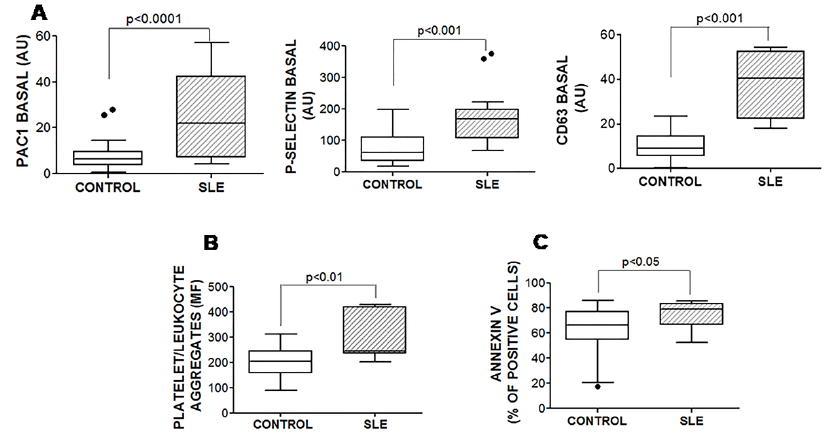
Figure 2. Basal activity of fibrinogen receptor, surface exposition of P-selectin,